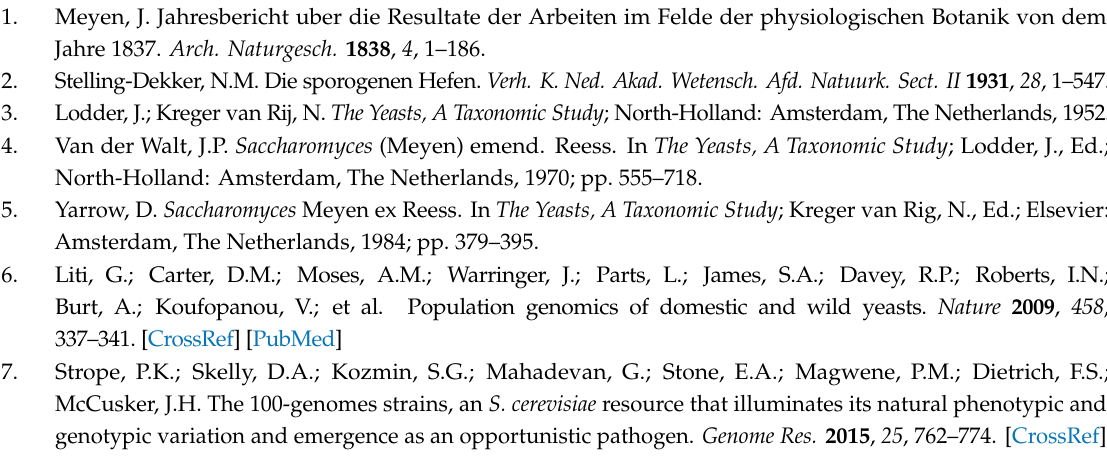
Figure S1: Unrooted phylogeny S. cerevisiae genomes representing the known diversity of the species, Figure S2: ◦ Brix measurements during growth in beer wort for 15 days at 25 ◦ C, Figure S3: Growth curves on 1% ( w / v ) melibiose medium supplemented with yeast nitrogen base and incubated at 25 ◦ C for three days, Table S1: Strains and genomes used in this study and relevant information pertaining to them, Table S2: Presence ( + ) or absence ( − ) of the MEL gene in the genomes of S. paradoxus from di ff erent